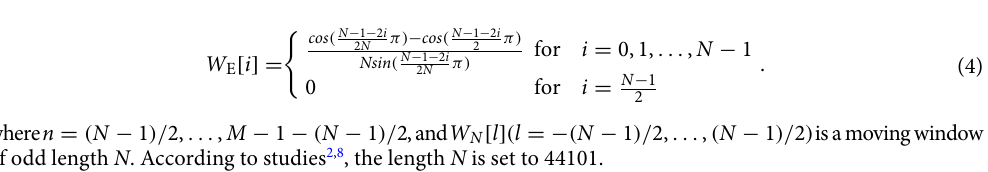
Figure 3. The automatic extraction procedures for CS 1 and CS 2 . A-B show the procedure for an example of a typical AR from the database in 26 . C-D show the procedure for an example of a typical normal sound database 27